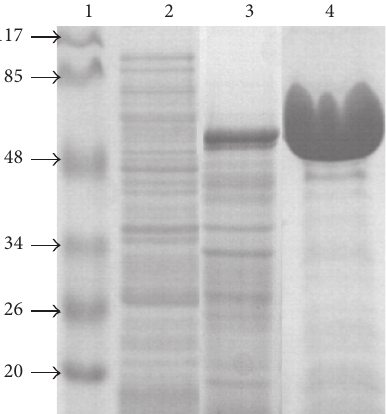
Figure 1: Expression and purification of recombinant glycosidase Asac 1390. SDS-PAGE was done using a 10.0% polyacrylamide gel; proteins were stained with Coomassie Brilliant Blue R-250. Lanes: 1—molecular weight markers (sizes are shown in kDa); 2—total protein from uninduced cells; 3—total protein from induced cells; 4—purified recombinant Asac 1390.